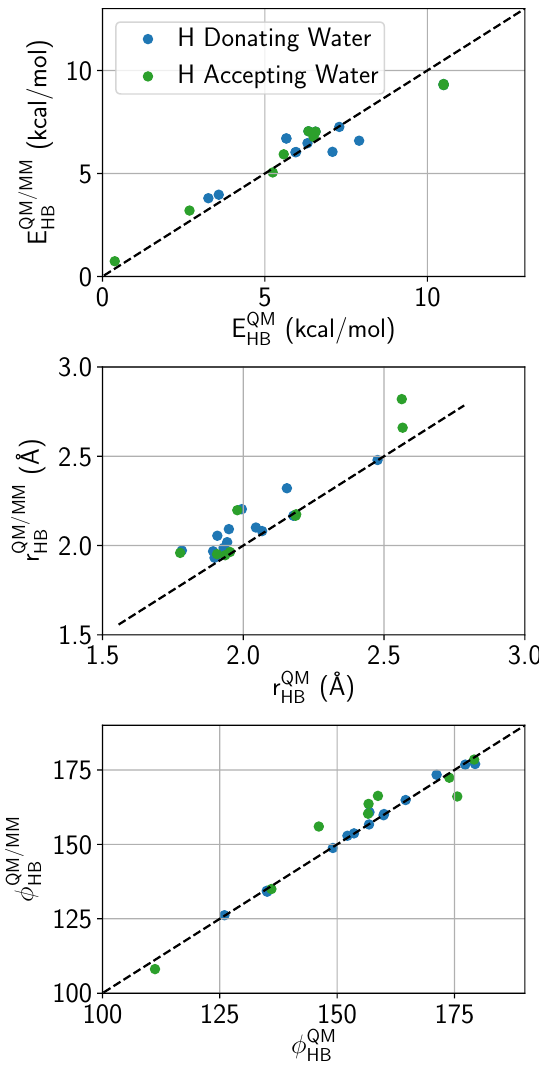
Figure A2. QM / MM vs. QM Correlations between hydrogen bond: binding energy ( top ); distance ( middle ); and angle ( bottom ). The dashed black lines represent the pure QM reference